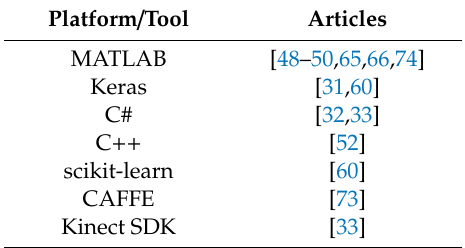
Figure 2. Breakdown of platforms and tools used. Table 5. Platforms and tools used in articles reviewed.